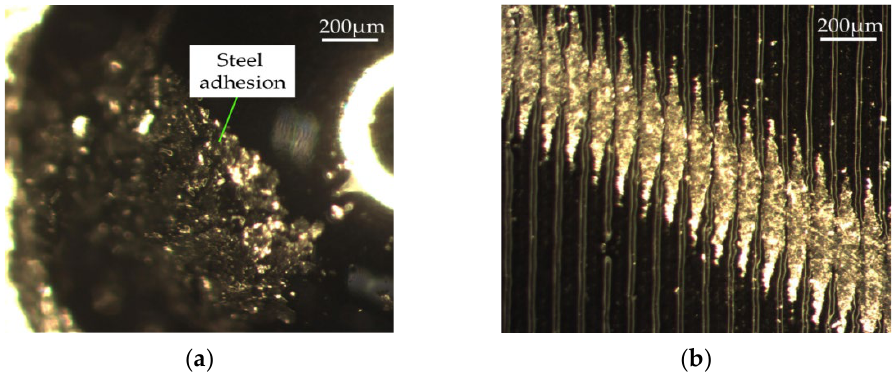
Figure 11. Stereoscopical macrographs: ( a ) Detail of the pin showing the steel adhesion; ( b ) Detail of